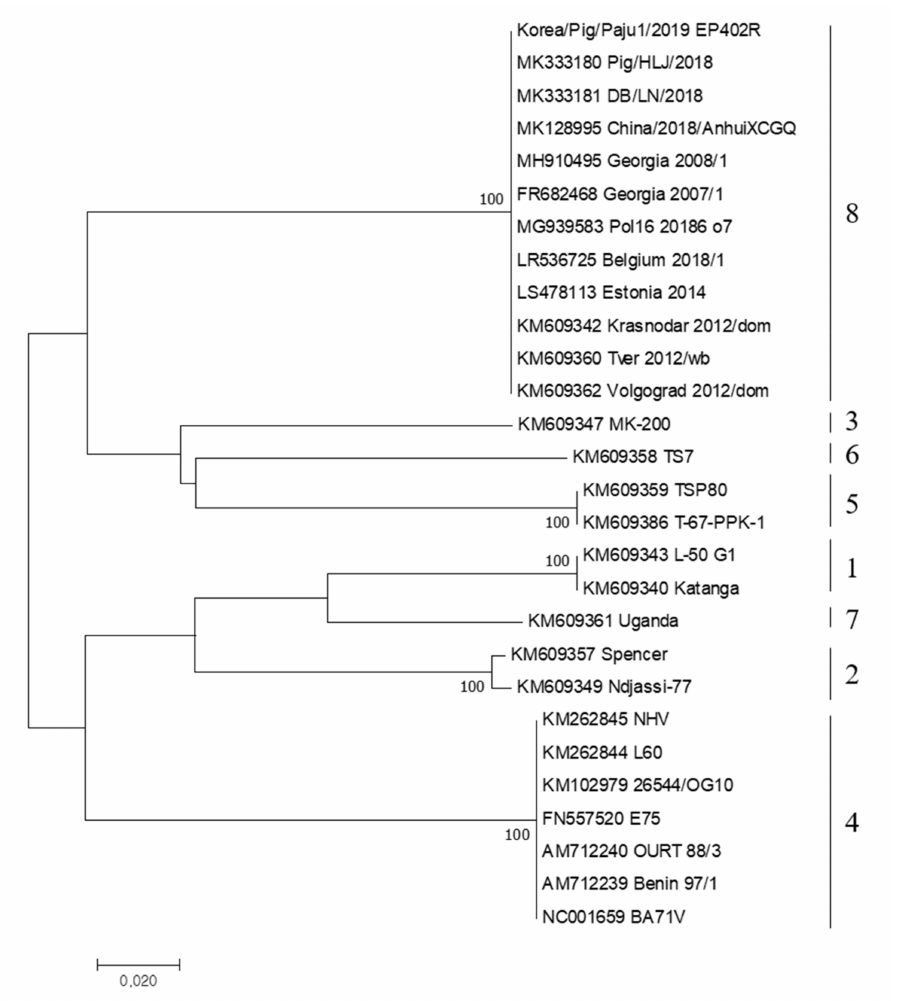
Figure 2. Phylogenetic tree of ASFV isolated in South Korea in 2019 based on partial sequence of CD2v serogroup. Neighbor-joining phylogenic tree was constructed using MEGA6.0 software.